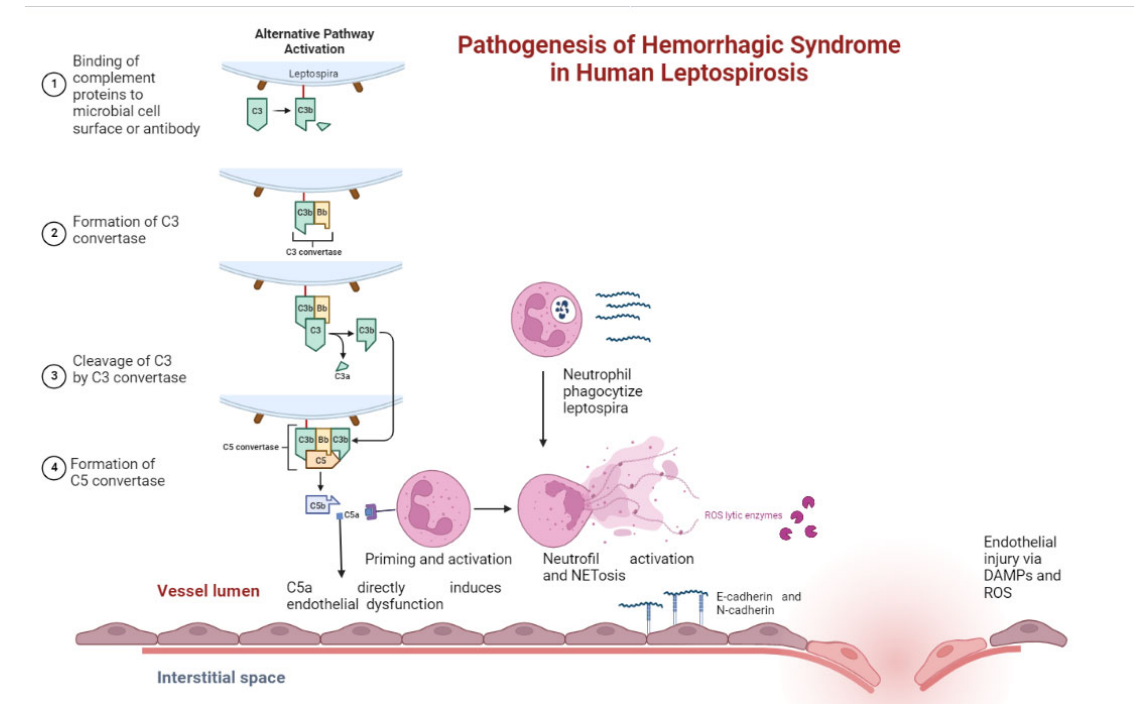
Figure 3. Pathogenesis of hemorrhagic syndrome in human leptospirosis.